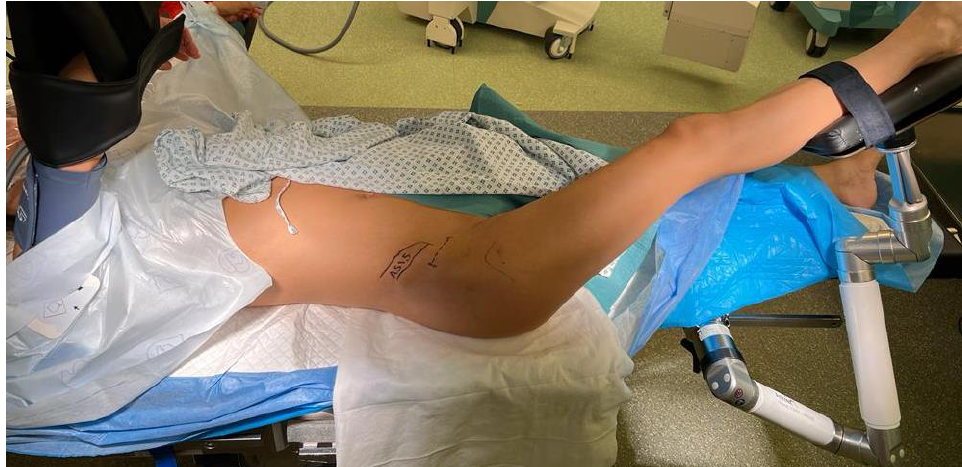
Figure 4. The skin incision (bikini incision; right hip) as shown by the dashed line runs parallel to the pelvic rim centered approximately 2 cm below the ASIS with a length of 5–8 cm in the iliac crease. The authors of this review use a robotic arm to allow for repositioning of the leg during surgery.